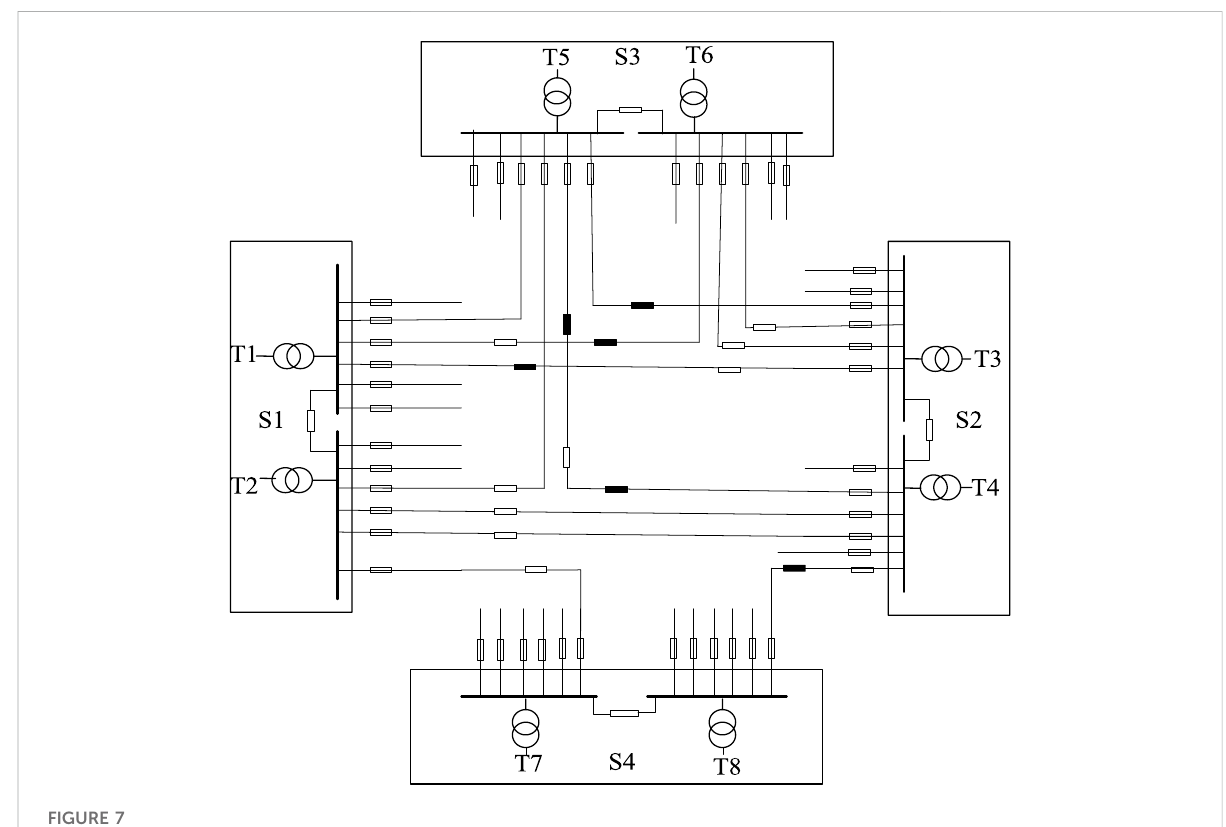
FIGURE 7 Illustration of case 5. The basic parameters are shown in Table